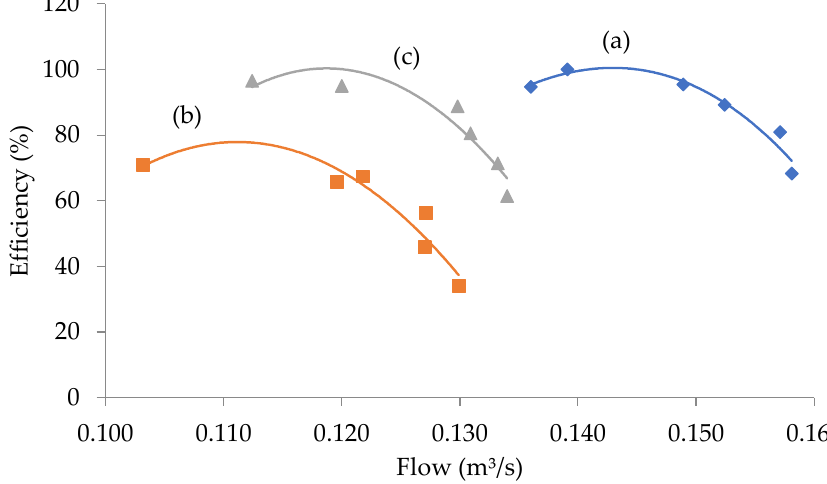
ff erent heads, constant and variable